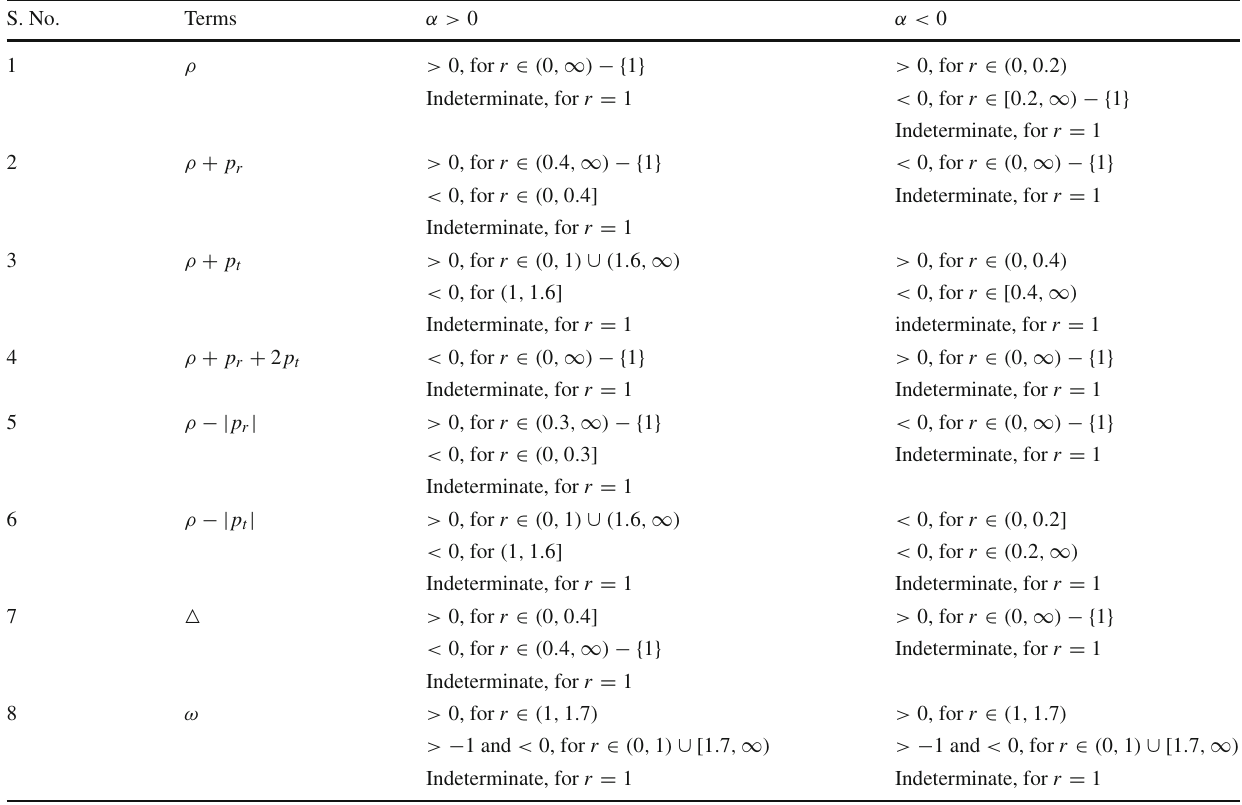
Table 7 Summary of results for φ( r ) = constant with n = − 1 S.